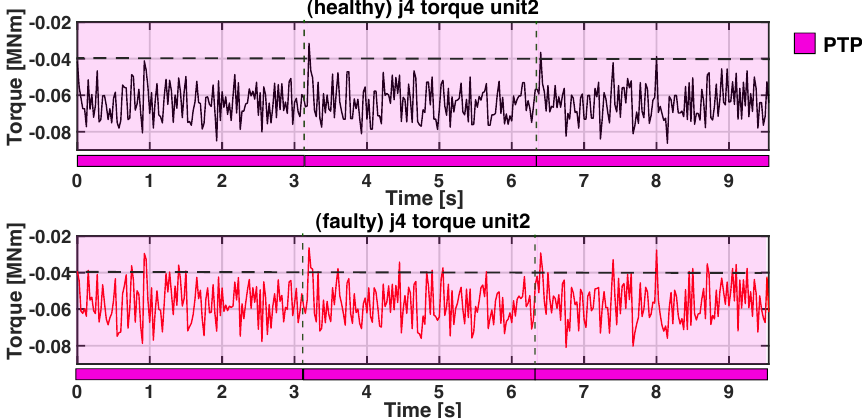
Figure 14. Data units 2 extraction. In this Figure, three subsequential joint torque units are represented which were extracted with the label “PTP(2)” from the acquisition of 2750 sample at 40 Hz. In black and in red, respectively, the 4th joint torque is under healthy and faulty conditions.